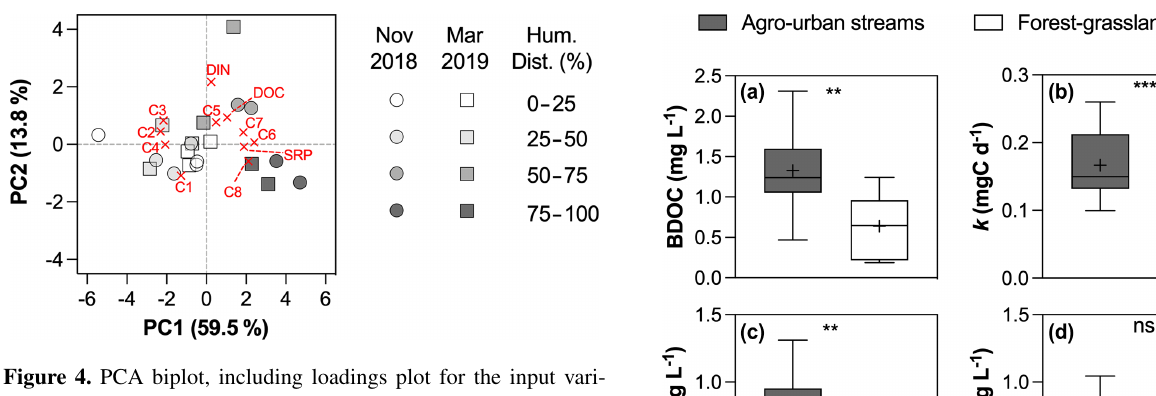
ties of PARAFAC components (Table 2), PC1